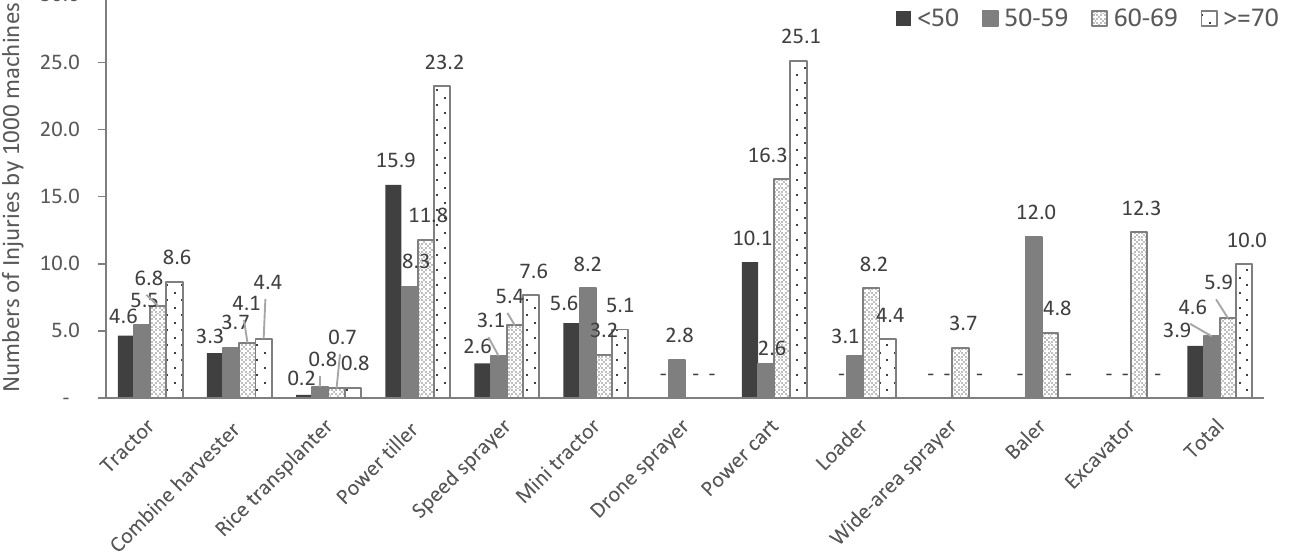
Figure 3. Incidence of injuries related to machines by type of machine and age among subscribers from 2014 to 2019. Table 2. Odds ratio (by logistic regression analysis) of the determinants of the occurrence of injuries related to agricultural